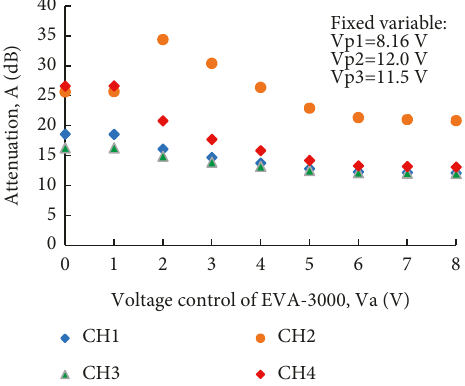
Figure 20: Attenuation, A q, of each channel when V aq varies from 0 to 8 V and V pp is kept constant.